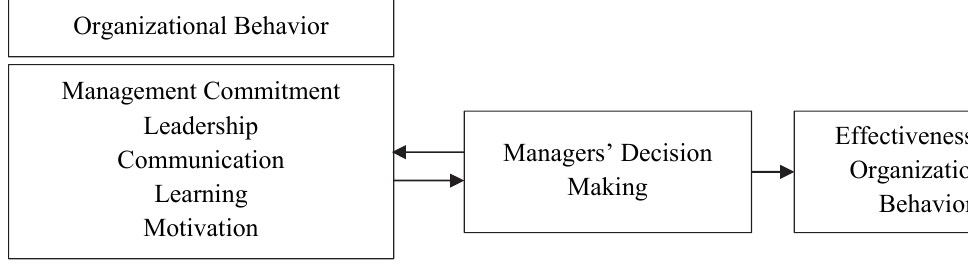
Fig. 1. Conceptual model of